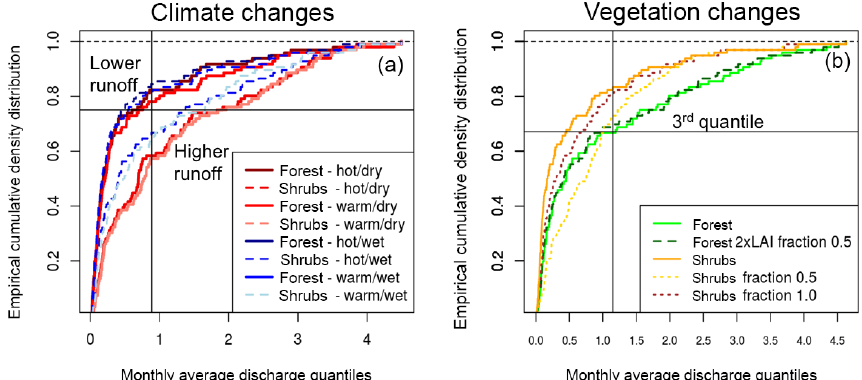
Figure 6. Cumulative density distributions are used here to illustrate the variations in (a) climate and (b) vegetation parameterizations for a single cell in the San Juan River basin. Climate alterations are shown for a hot/wet, hot/dry, warm/wet and warm/dry scenarios for both forest and shrubs. For the vegetation parameterization, forests, forests with 2 times leaf area index (LAI), shrubs, and shrubs with fractions of 0.5 and 1.0 are shown. A shrub fraction of 1 indicates that there are no spaces between the plants. The third quantile in the average of the distributions is indicated in each plot with intersecting